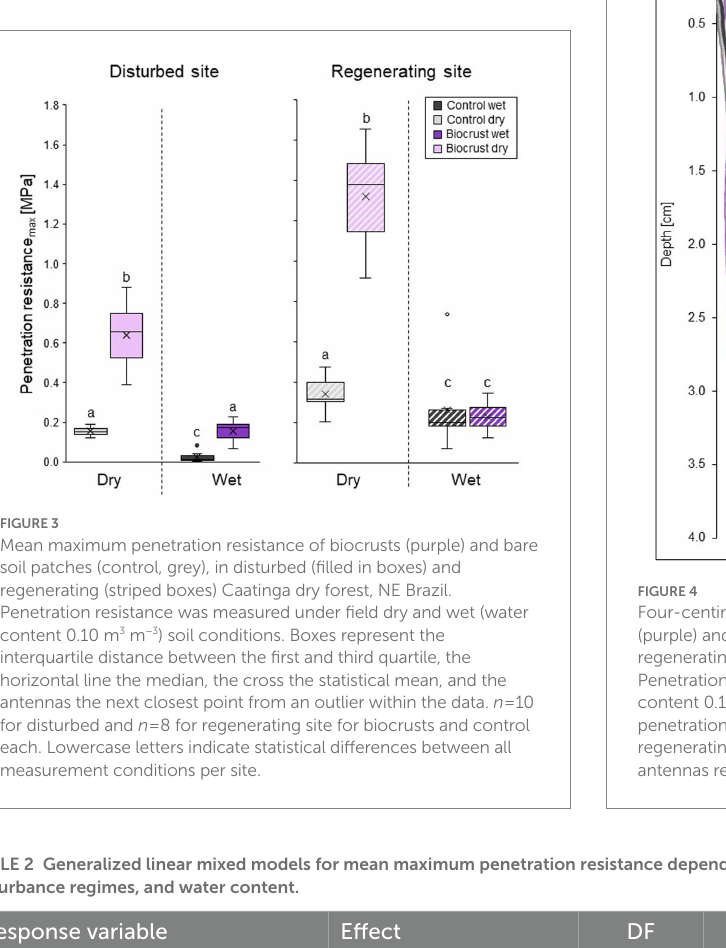
Response variable